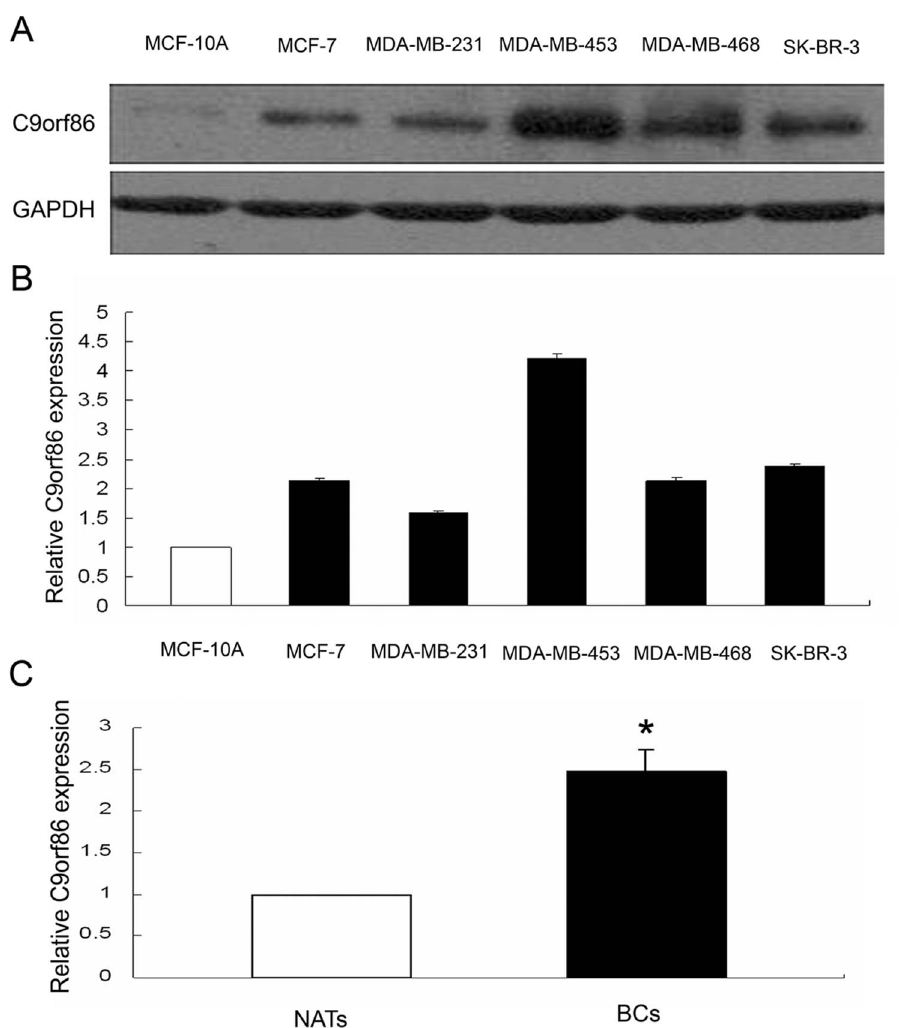
Figure 1. C9orf86 expression in breast cancer cells and tissues. Expression of C9orf86 was quantified in human breast cancer (lanes 2–6), and normal (lane 1) breast epithelial cells by Western blot (A) and qRT-PCR (B). (C) QRT-PCR shows that expression of C9orf86 is increased in invasive BC tissues compared with NATs (P , 0.05). Western blotting and RT-PCR were performed using glyceraldehyde-3-phosphate dehydrogenase (GAPDH) as a